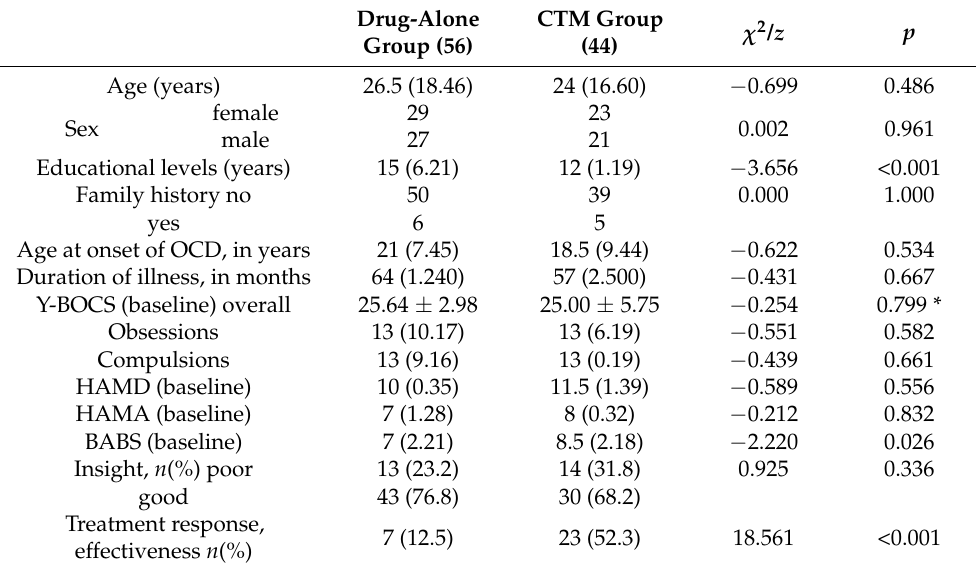
Table 1. General clinical features and scale between drug-alone group and CTM group.